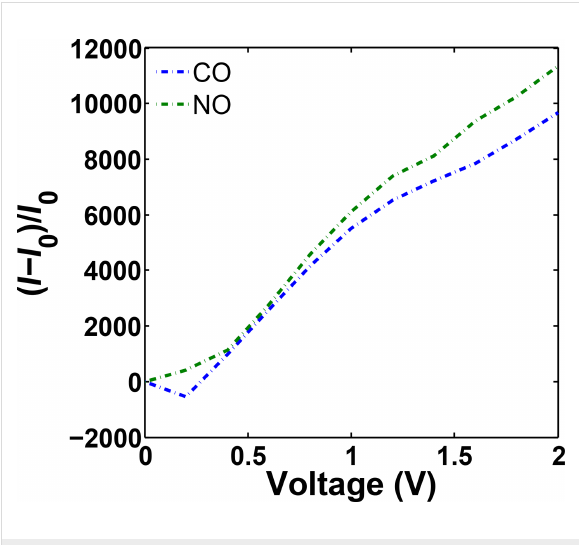
Figure 8: Sensitivity of the armchair graphene nanoribbon (AGNR) in the presence of CO and NO